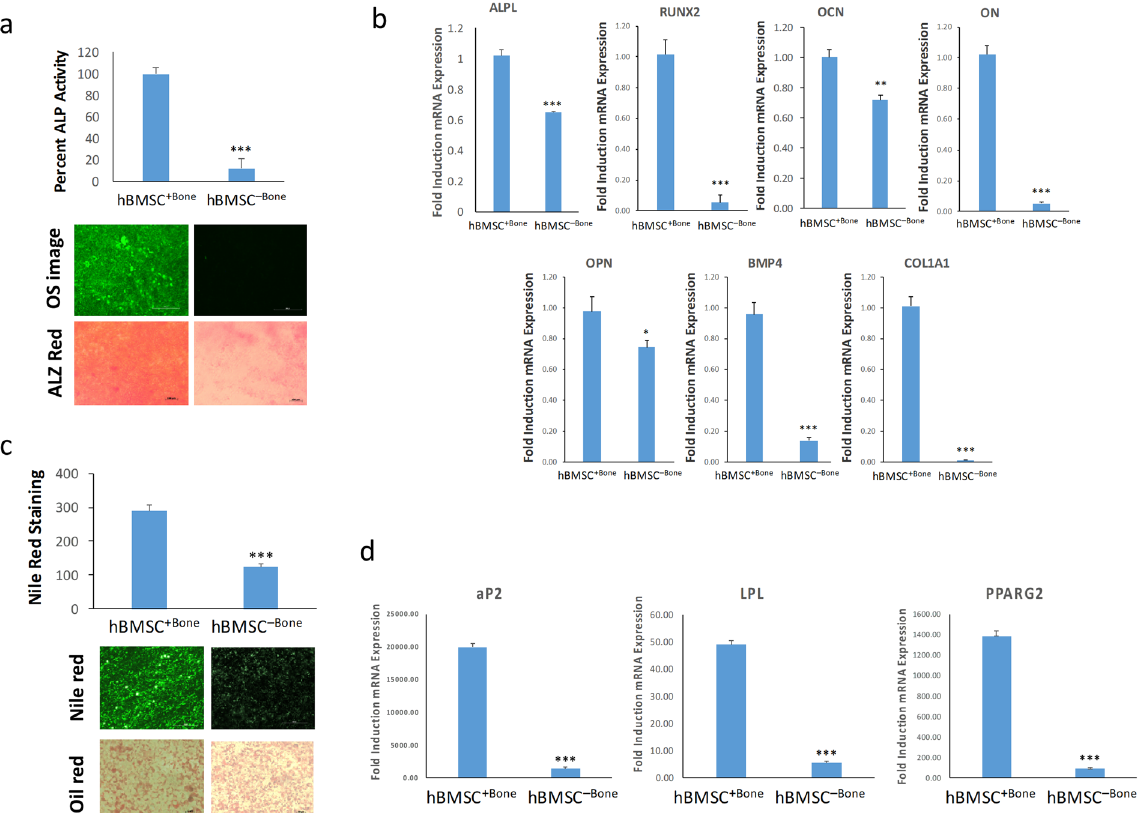
Figure 1. Functional heterogeneity of bone- and non-bone- forming hBMSC clones. (a) Quantification of percent ALP activity on day 14. Data is presented as the means ± SD of three independent experiments; n = 6; *** p < 0.0005. The upper image panel shows OsteoImage ™ staining, while the lower panel shows Alizarin Red S staining. (b) qRT-PCR quantification of ALPL, RUNX2, OCN, ON, OPN, BMP4, and COL1A1 osteoblast markers under osteoblastic induction conditions. The expression of each target gene was normalized to GAPDH . Data are presented as mean ± SD from three independent experiments, n = 9; * p < 0.05; ** p < 0.005, *** p < 0.0005. (c) Nile red quantification of mature adipocytes on day 7 post adipocyte induction of the indicated hBMSC clone. Data are presented as mean ± SD, n = 9 from three independent experiments. *** p < 0.0005. Upper panel shows Nile red staining of mature oil filled adipocytes, while the lower panel shows oil red O staining for adipocyte (20 × magnification). (d) qRT-PCR quantification for aP2, LPL and PPAR γ 2 . The expression of each target gene was normalized to GAPDH . Data is presented as the means ± SD from three independent experiments, n = 9; *** p <